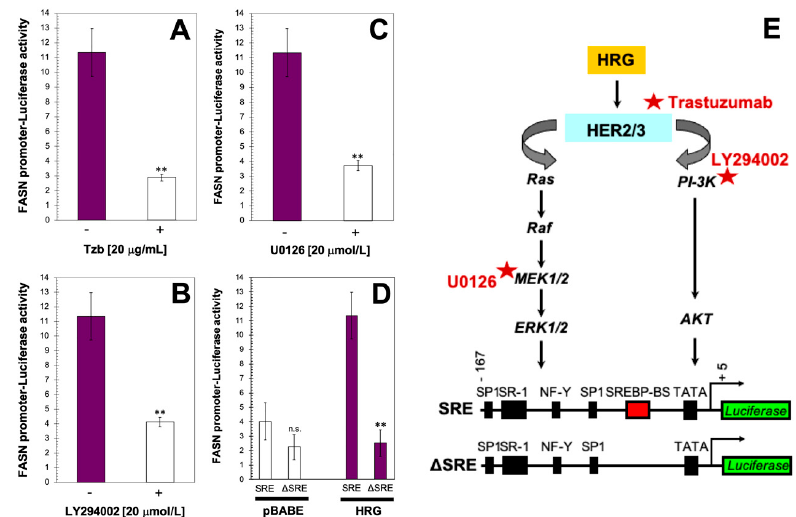
Figure 2. PI-3K / AKT and MAPK ERK1 / 2 signaling cascades mediate heregulin-driven activation of FASN gene expression in a SBREP-dependent manner. MCF-7 / HRG cells were transiently transfected with a plasmid containing a Luciferase reporter gene driven by a 178-bp FASN gene promoter fragment harboring a SREBP-binding site, flanked by auxiliary NF-Y and Sp-1 sites. The next day, cells were treated with 20 µ g / mL of trastuzumab (Tzb) ( A ), LY294002 ( B ), or U0126 ( C ). Alternatively, MCF-7 / pBABE and MCF-7 / HRG cells were transiently transfected with a plasmid containing a Luciferase reporter gene driven by a 178-bp FASN promoter fragment harboring a SREBP-binding site or with a similar construct with the SREBP-binding site deleted ( D ). After 24 h, cells were lysed and Luciferase activity was measured. Luciferase assays were performed as previously described [19,20]. Each experimental value represents the mean fold increase (columns) ± S.D. (bars) from at least three separate experiments in which triplicate wells were measured. ** p < 0.005; n.s. not statistically significant. ( E ) HRG-triggered regulatory cascade actively links upstream HER2 transactivation and increased activation of PI-3K / AKT-MAPK / ERK1 / 2 signaling transduction with downstream (SREBP-dependent) transcriptional activation of the FASN gene